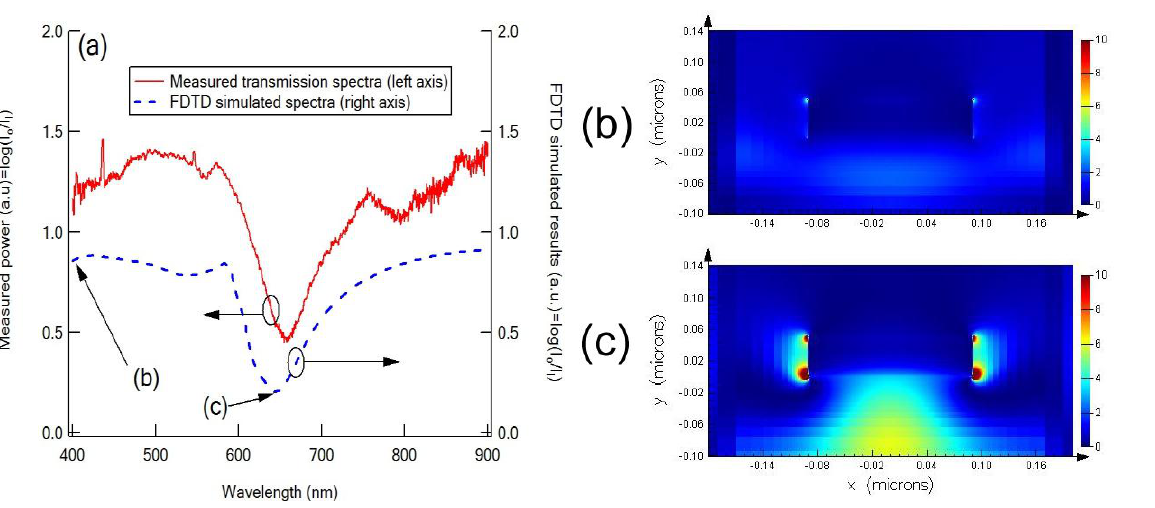
Figure 7. The measured and simulated transmission spectra for the nanodot array in air (a) , and the intensity of the electric field around the nanodots for 400 nm (b) and 650 nm (c)